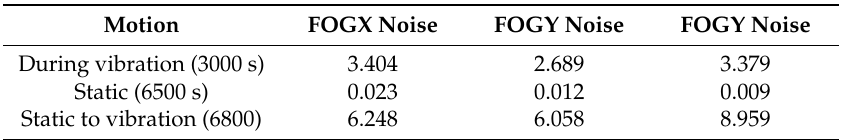
Table 2. The variance of the